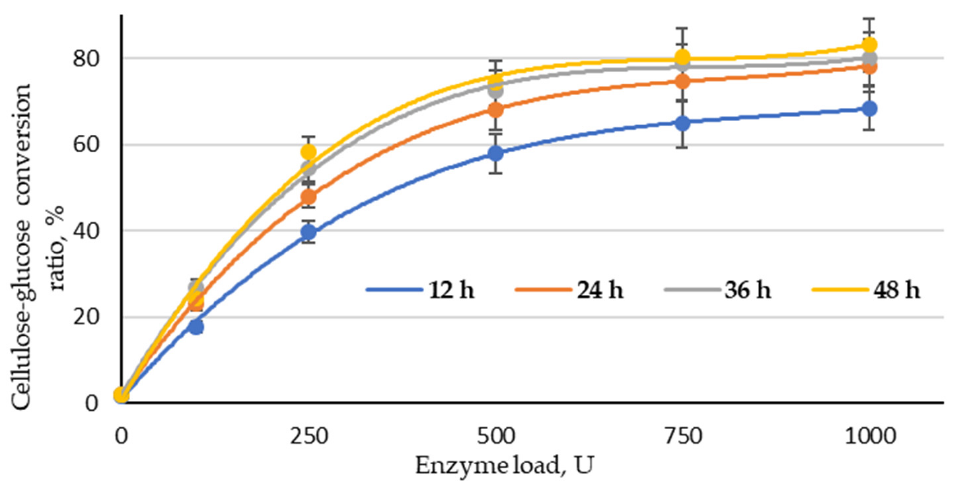
Figure 7. Cellulose–glucose conversion ratio depending on enzyme load and reaction time (LC residue sample treated with an H 3 PO 4 /NaH 2 PO 4 catalyst mixture at a ratio of 1:1).